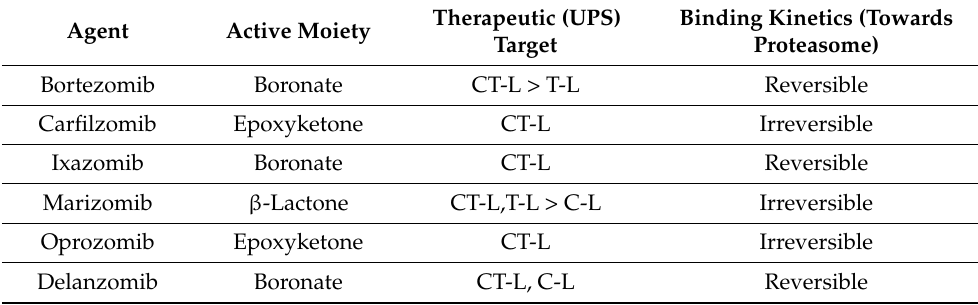
Table 1. Chemical and pharmacological characteristics of various proteasome